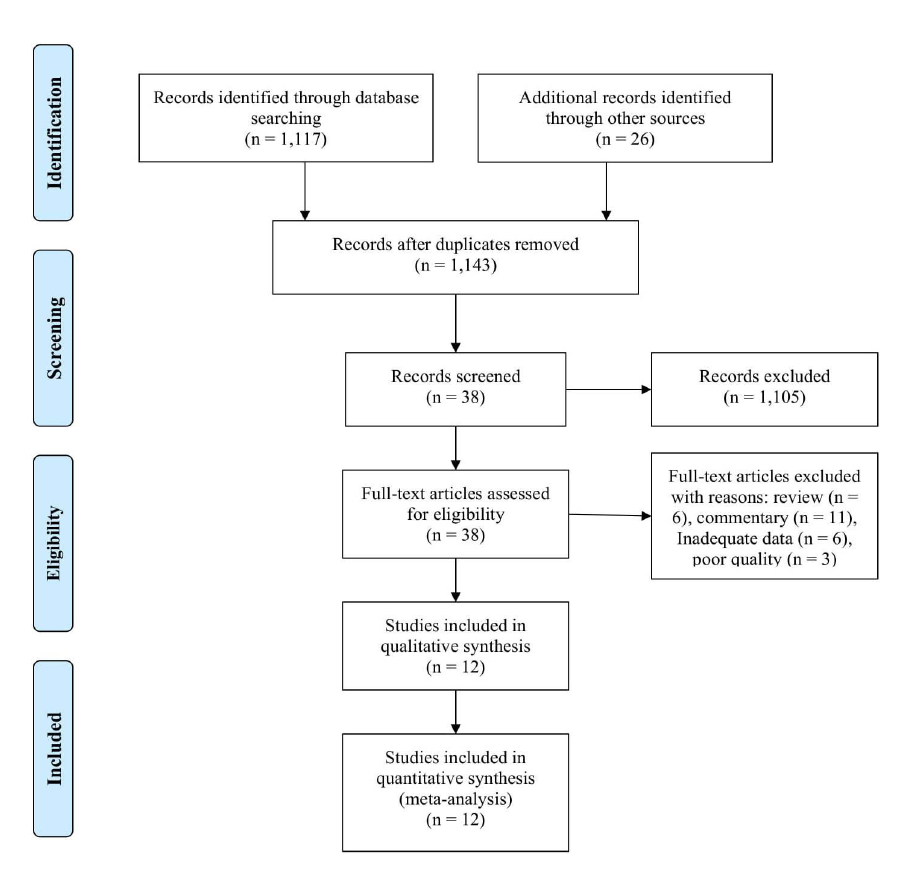
Figure 1. A flowchart of study selection in our